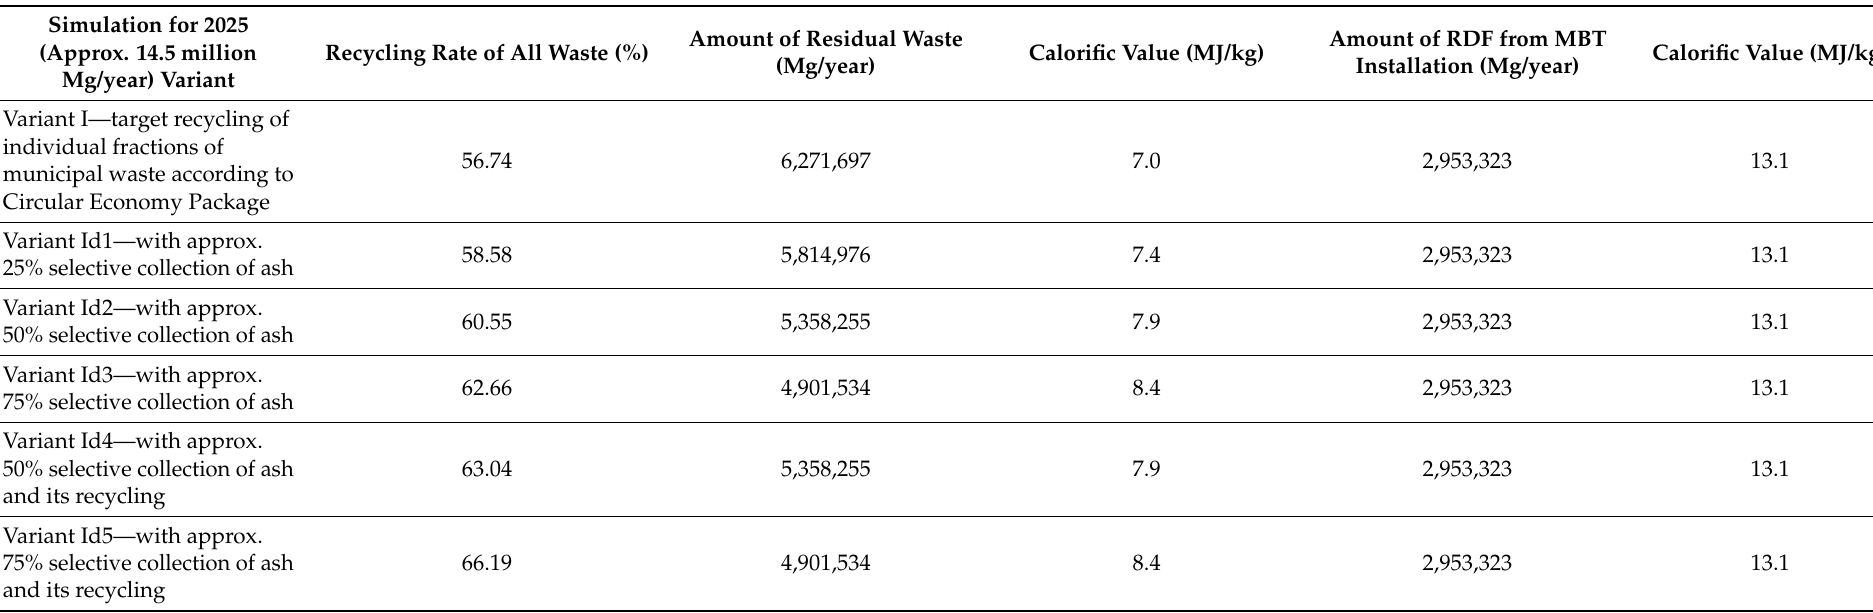
Table 14. The amount and calorific value of residual waste and RDF for various variants of the Circular Economy Package implementation—the impact of selective collection of bottom ash. Simulation for